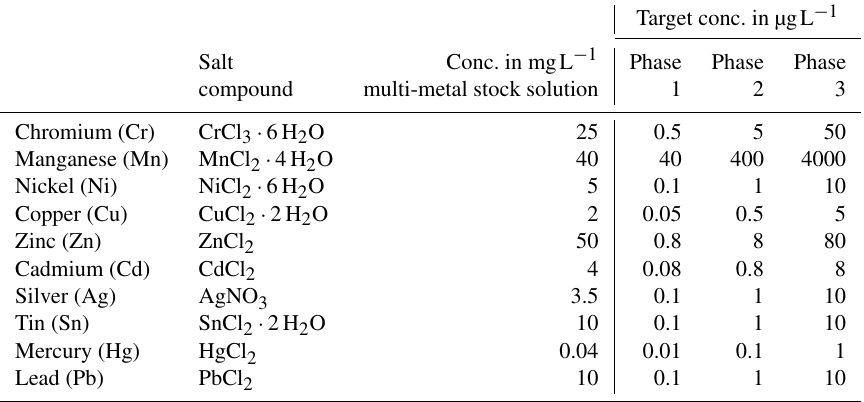
Table 1. Heavy metal concentration in the multi-metal stock solution, target concentration of these metals in each phase and salt compounds used. All salts used were provided in pro analysi quality and were purchased from Carl Roth (CrCl 3 · 6H 2 O, SnCl 2 · 2H 2 O and PbCl 2